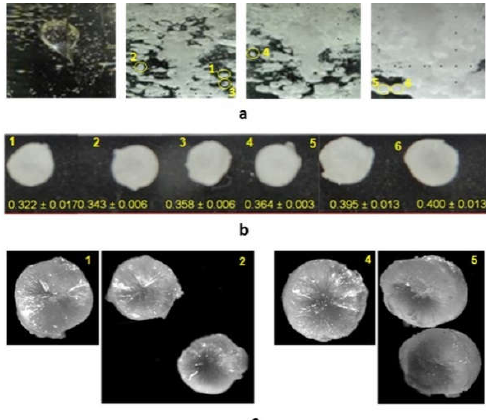
Figure 8. Xylitol crystallization pictures: ( a ) small air bubbles are dragged by the liquid circulation cell then white solid particles are formed by crystallization of Xylitol on the air bubbles surface. Finally, numerous solid particles can be observed in suspension; ( b ) Pictures of 6 particles extracted from the beaker and measured using a caliper (dimensions are given in millimeters); ( c ) magnified pictures of the cross-sections of particles cut in half.